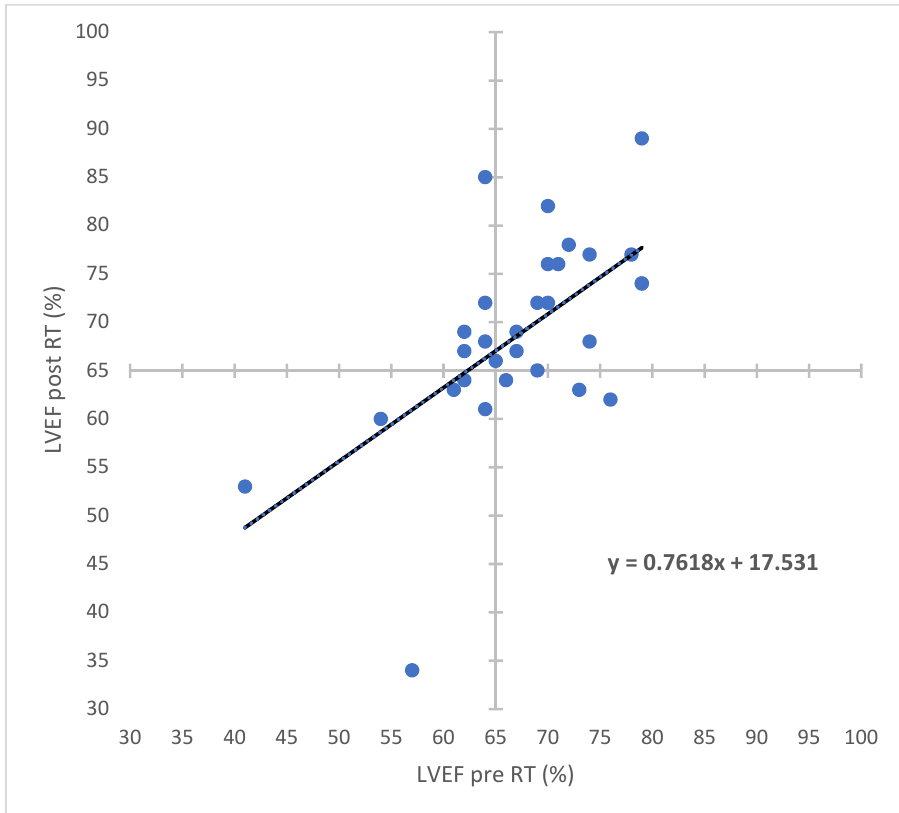
y = 0.7618x + 17.531